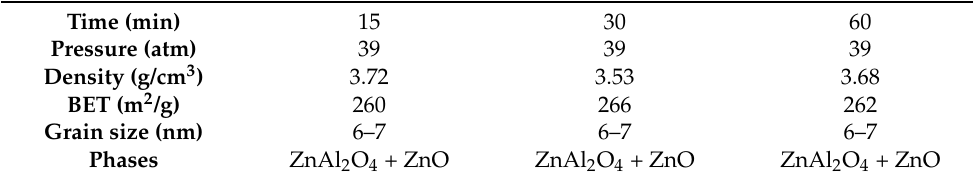
Table 1. Results of zinc-aluminum spinel